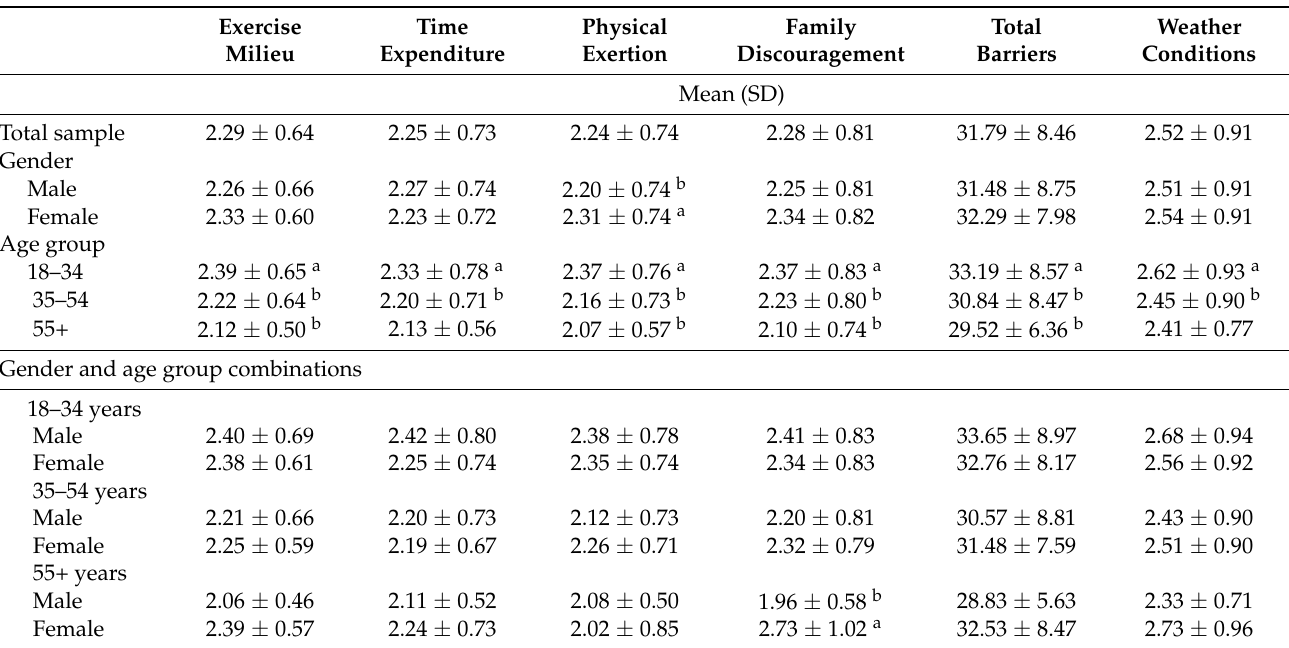
Table 2. Physical activity barriers by gender and age